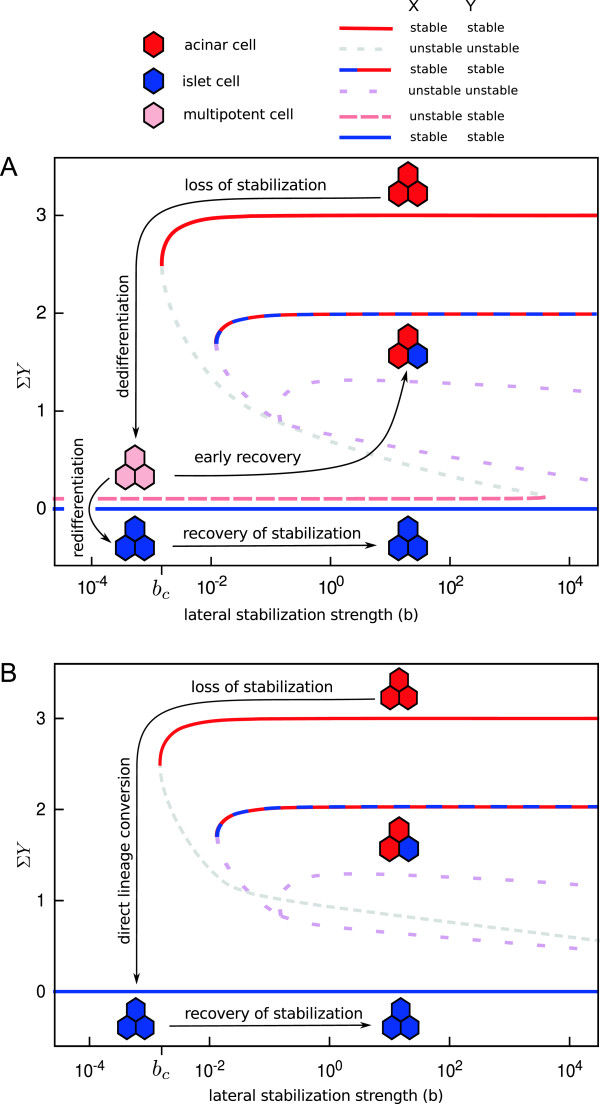
Bifurcation analysis. Stability of cell fates change as a function of strength of lateral stabilization. Bifurcation diagram showing stable attractors (solid) and unstable states (dashed) for a minimal tissue consisting of three-cells (hexagons). Arrows indicate trajectories after loss of stabilization. (A) In presence of lateral inhibition, a>ac, loss of stabilization, b<bc, causes dedifferentiation towards a progenitor-like multipotent state. If lateral stabilization is recovered at this early stage, the developmental process is recapitulated and a mixed pattern of both cell fates arises. In contrast, if stabilization remains inhibited, cells redifferentiate into islet cells. (B) In absence of lateral inhibition, a<ac, loss of stabilization results in direct lineage conversion, due to the absence of a progenitor-like multipotent state. This unstable multipotent state vanishes at ac in a saddle-node bifurcation with another solution branch of similar Y-values but higher Z activity which is additionally unstable against perturbations in Z and therefore omitted in (A). Note that ΣY is a projection of a high (12)-dimensional space, such that intersections do not imply bifurcations or changes in stability as these need not intersect in the actual state space. In the legend, the stability of X or Y means (un)stable with respect to perturbations in variable X or Y, respectively. With parameters as in Table 1, ac≈0.0017 and bc≈0.012.